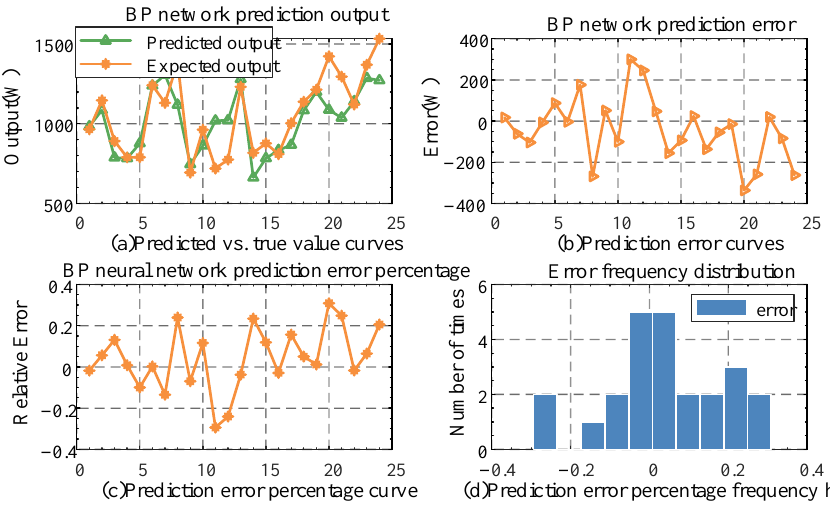
Figure 3. The predictive power of the BP neural network was improved by the genetic algorithm.